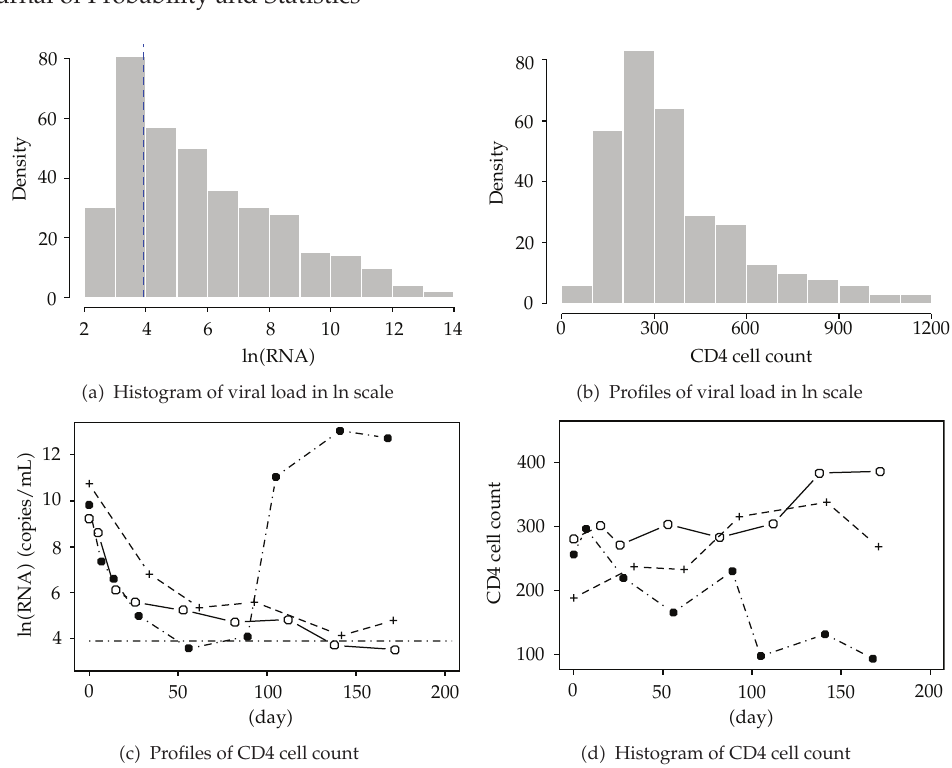
Figure 1: The histograms (cid:3) a,b (cid:4) of viral load measured from RNA levels (cid:3) in natural ln scale (cid:4) and standardized CD4 cell count in plasma for 44 patients in an AIDS clinical trial study. Profiles (cid:3) c,d (cid:4) of viral load (cid:3) response (cid:4) in ln scale and CD4 cell count (cid:3) covariate (cid:4) for three randomly selected patients. The vertical and horizontal lines in (cid:3) a (cid:4) and (cid:3) c (cid:4) are below the detectable level of viral load (cid:3) 3 . 91 (cid:7) ln (cid:3) 50 (cid:4)(cid:4)